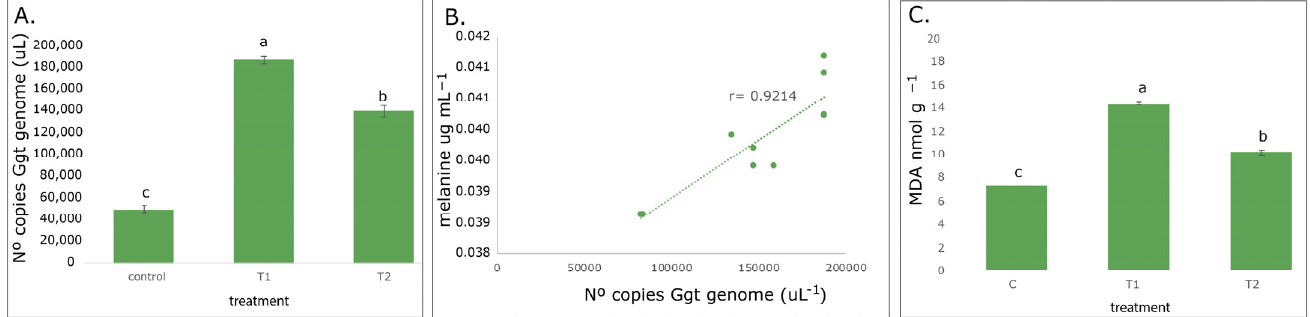
Figure 4. ( A ) Number of Ggt genome copies in infected roots 60 days after inoculation with 1% of Ggt. ( B ) Correlation between melanin concentration and Ggt genome copy number. ( C ) Lipid peroxidation measured as TBARS (thiobarbituric acid reactive substance) roots. (c) control, inducer factors T1: UV-A, T2: temperature variation (30, 15 and 20 °C). Different letters denote significant difference ( p ≤ 0.05).